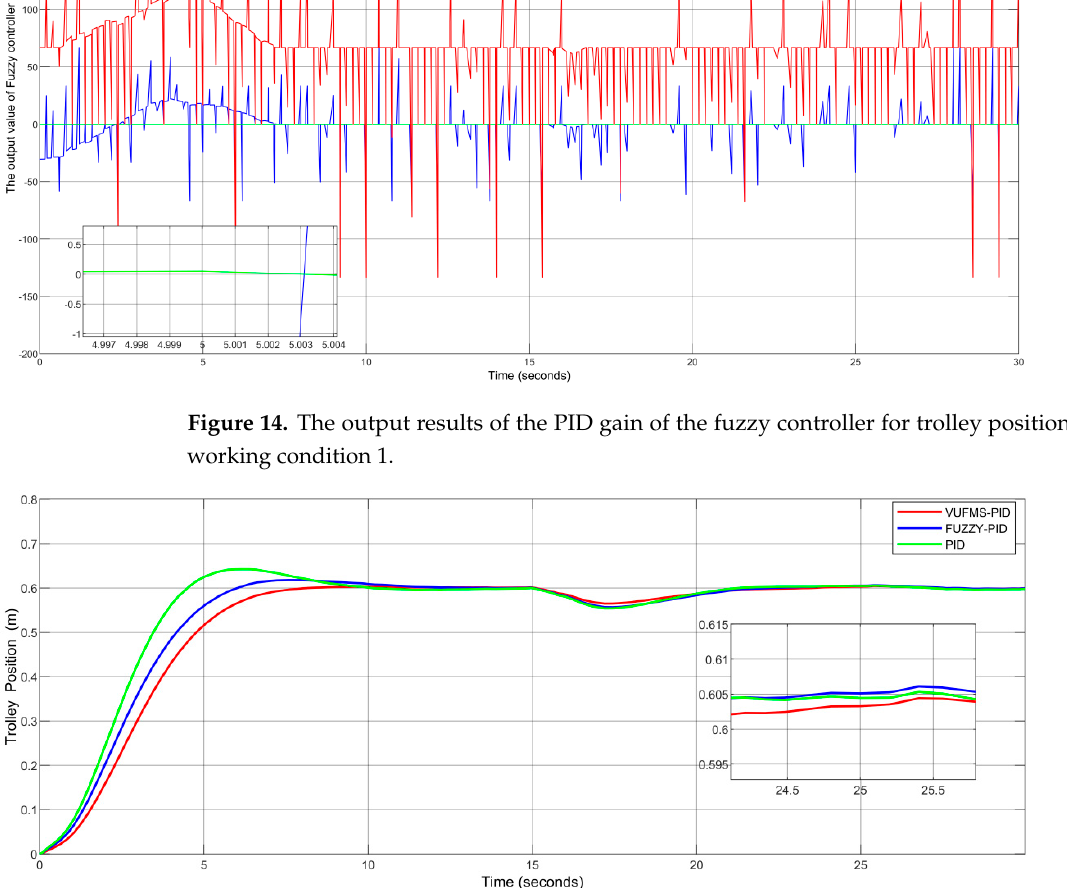
Figure 14. The output results of the PID gain of the fuzzy controller for trolley positioning under working condition 1. Table 9. Parameters of the crane under four working conditions.